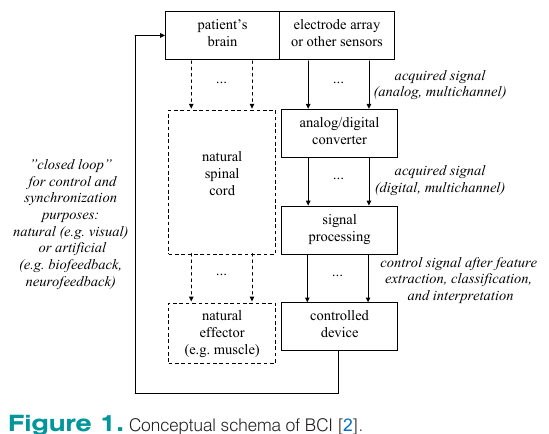
Figure 1. Conceptual schema of BCI [ 2